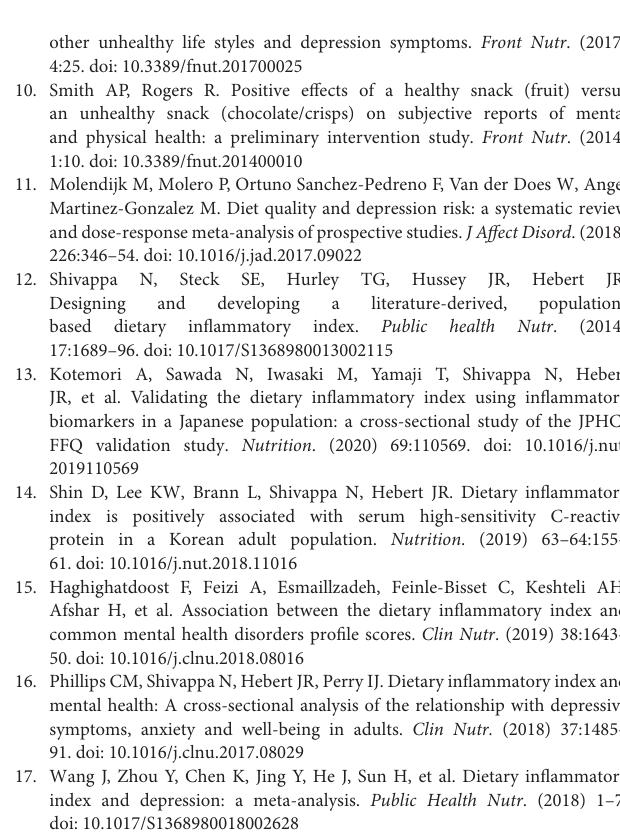
Supplementary Table 1 | PRISMA Checklist. Supplementary Table 2 | Methodological quality of the included